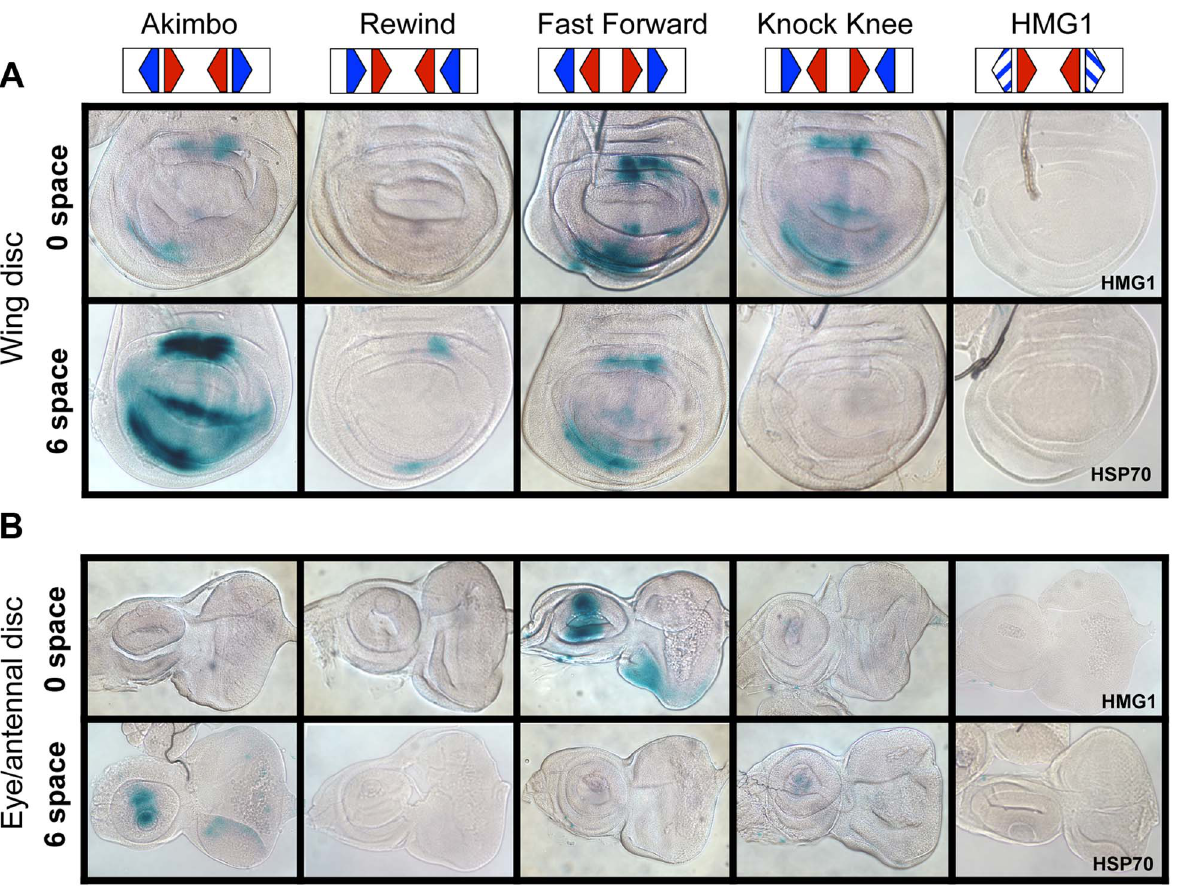
Figure 4. HMG-Helper pair configuration preferences in imaginal discs. Brightfield images of imaginal discs from 3 rd instar larva containing the indicated lacZ reporter constructs stained for lacZ activity. (A) Wing imaginal discs. (B) Eye/antennal discs. The FF0 and AK6 reporters display the highest expression in these tissues. Neither the promoter alone (HSP70) nor the HMG site only (HMG1 shown) constructs have detectable expression. At least 20 discs for each reporter were analyzed, with representative images shown. The same base pair sequences used in Figure 3 were utilized for the transgenic reporters (see Table S1 for sequences).